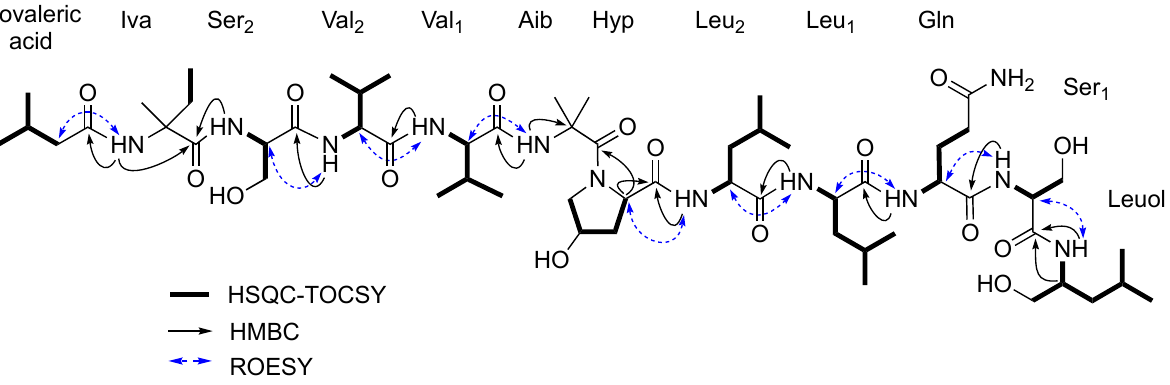
Figure 2. Key HSQC ‐ TOCSY, HMBC, and ROESY correlations for roseabol A ( 1 ). Figure 2. Key HSQC-TOCSY, HMBC, and ROESY correlations for roseabol A ( 1 ). The sequence of roseabol A ( 1 ) deduced from the NMR experiments was also sup- ported by ESI-MS/MS collision-induced dissociation analysis. The fragmentation of 1 provided two ions at m / z 554.3616 (C 27 H 48 N 5 O 7 ) and m / z 672.4314 (C 31 H 58 N 7 O 9 ), which were derived from cleavage of the bond between Aib and Hyp to form y 6 and b 5 seg- ments [1]. Further analysis of the ESI-MS/MS data revealed a series of a- and b-type fragments ( m / z 1021, 894, 469, 441, 370, 271, and 156) and x- and y-type fragments ( m / z 982, 333, 248, and 118), which were in good agreement with the sequential loss of the assigned amino acid residues of 1 from the C -terminus and N -terminus, respectively (Figure 3 and Figure S10). Thus, the planar structure of roseabol A ( 1 ) was